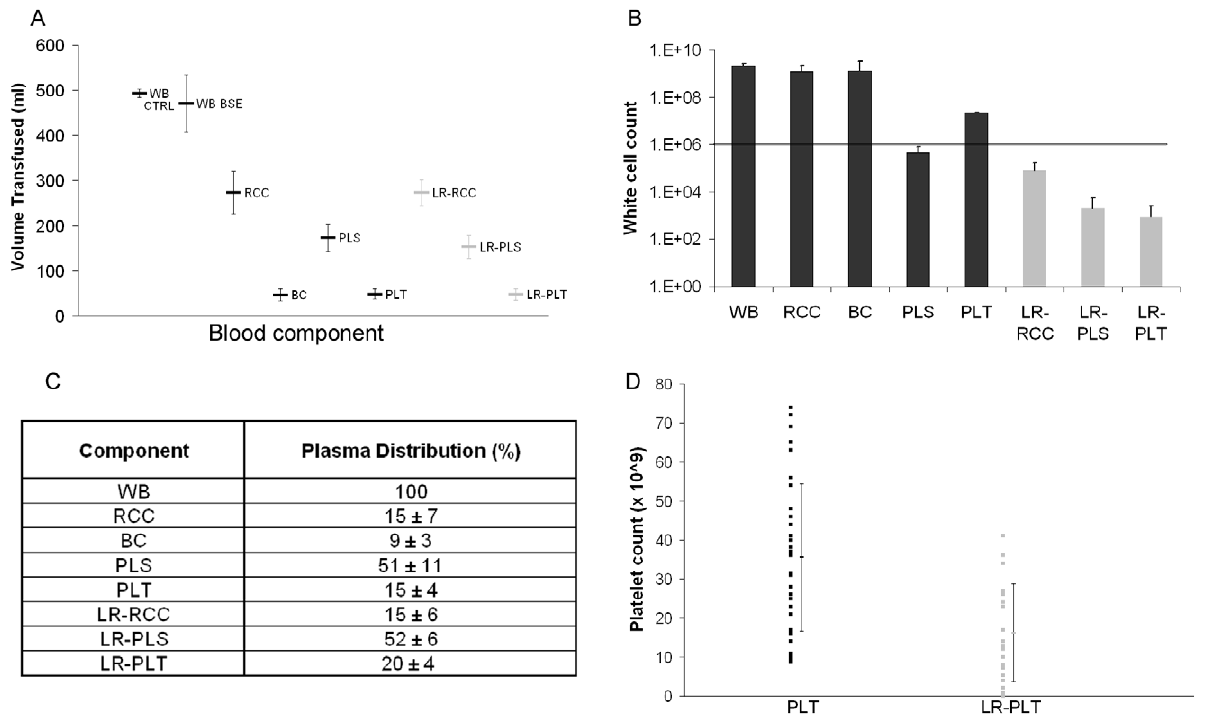
Figure 3. Analysis of sheep blood components. Graph A shows the range and average volume ( 6 1SD) of each component used for transfusion. No difference was observed in the volume between leucoreduced (grey bars) and non-leucoreduced components (black bars). White cell counts were calculated using Leucocount TM kits and flow cytometry. All leucoreduced components from sheep (grey bars) meet the specifications assigned to human equivalents and contained less that 1 6 10 6 residual leucocytes (as shown by the solid line, graph B). Following the separation of whole blood, the majority of the total plasma volume was distributed in association with plasma unit. The remaining plasma volume was differentially distributed in red cells, platelets and buffy coat, (panel C) as a percentage of the total plasma volume. No major differences were observed in plasma distribution between leucodepleted and non-leucodepleted components. The number of platelets in platelet concentrates prepared from leucoreduced and non- leucoreduced components was highly variable in sheep and the average count was statistically significantly different (p , 1 6 10 2 5 , using 2-tailed Student’s t-test, graph D).